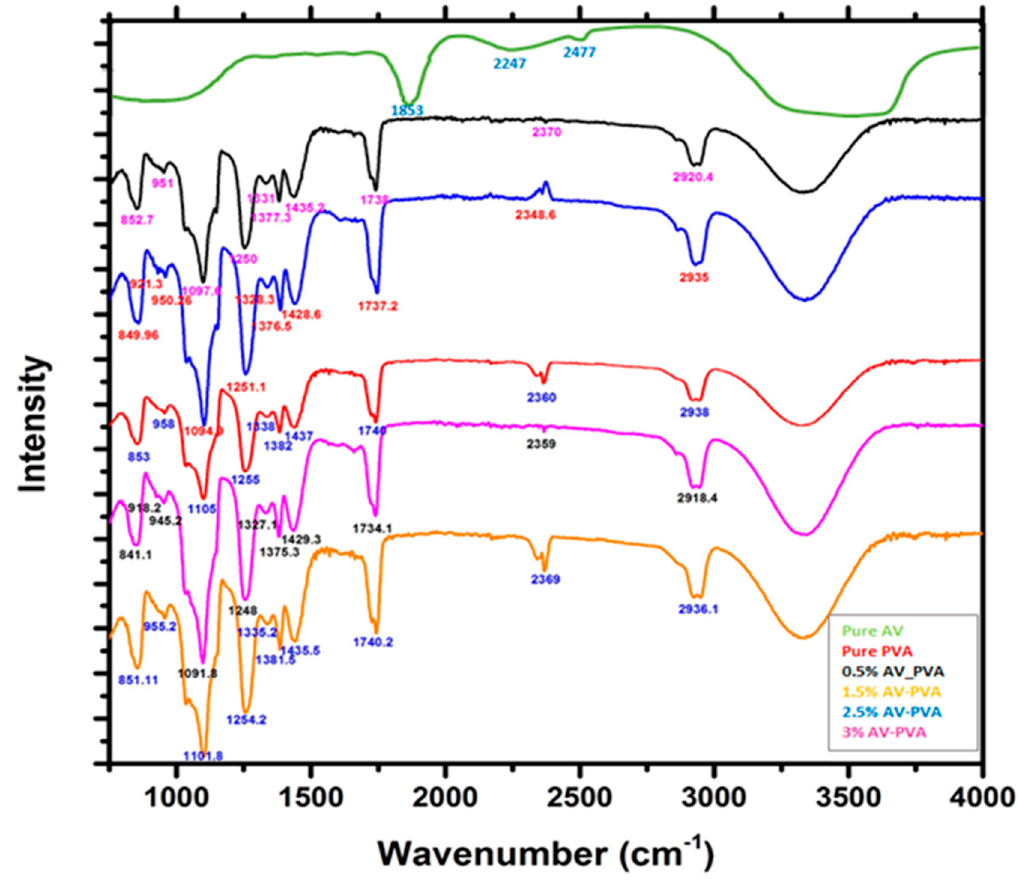
Figure 5. FTIR spectra of pure PVA, 0.5%, 1.5%, 2.5%, and 3% AV/PVA electrospun nanofibers.